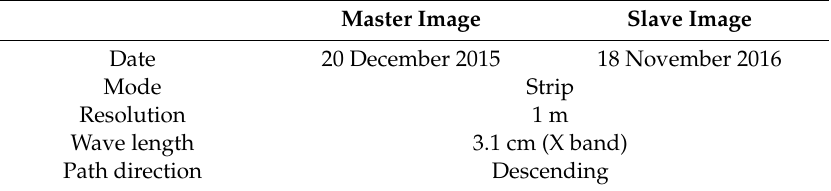
Table 5. Yaogan-29 satellite data of the experimental area (Dengfeng area,